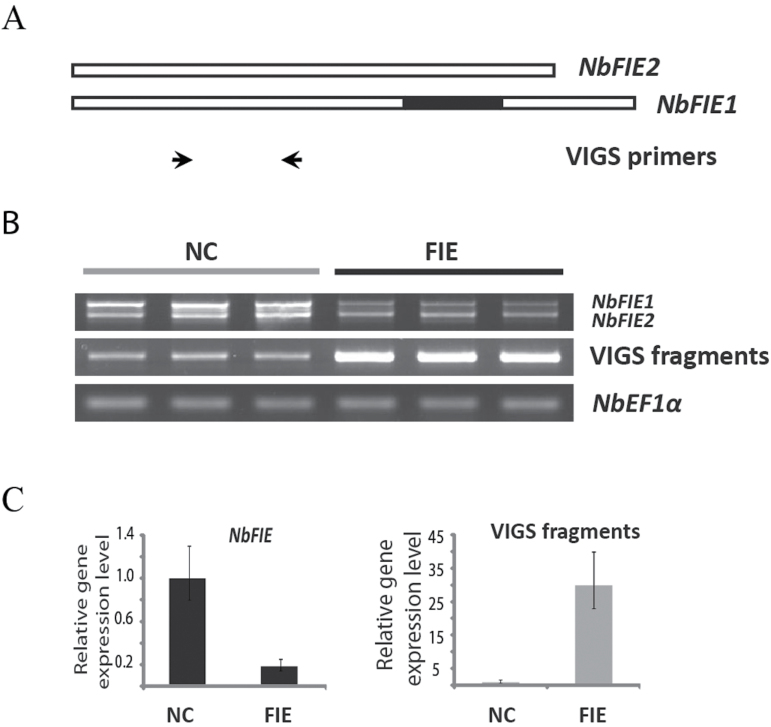
VIGS experiments of NbFIE genes. (A) Schematic depiction of the structures of the NbFIE1 and NbFIE2 coding sequences and the positions of the primers of VIGS used. The black bar represented the specific 157bp cDNA sequence of NbFIE1. The arrowheads marked the positions of the primers. (B) Semi-quantitative RT-PCR of NbFIE genes and VIGS fragments in control plants and NbFIE silenced plants at 21 days after infiltration (DAI). (C) Real-time qRT-PCR of NbFIE genes and VIGS fragments in control plants and NbFIE silenced plants at 21 DAI. Plant shoot and leaf tissues above infiltrated leaves were used for RNA extraction and RT-PCR. The NbEF1α gene was used as the internal standard. NC, control; FIE, NbFIE silenced plants. Error bars indicate standard deviation calculated from three technical repeats.